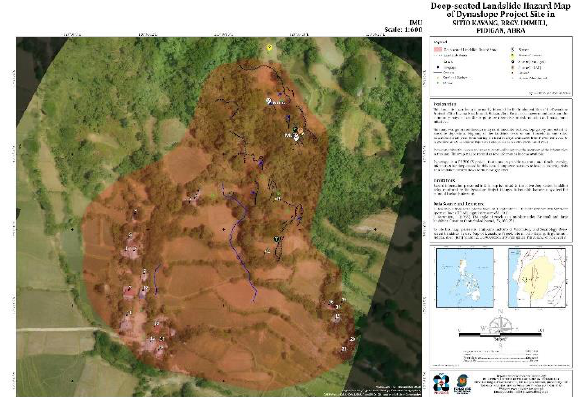
Figure 2 . Deep-Seated Landslide Hazard Map in Pidigan, Abra (PHIVOLCS Dynaslope, 2019).